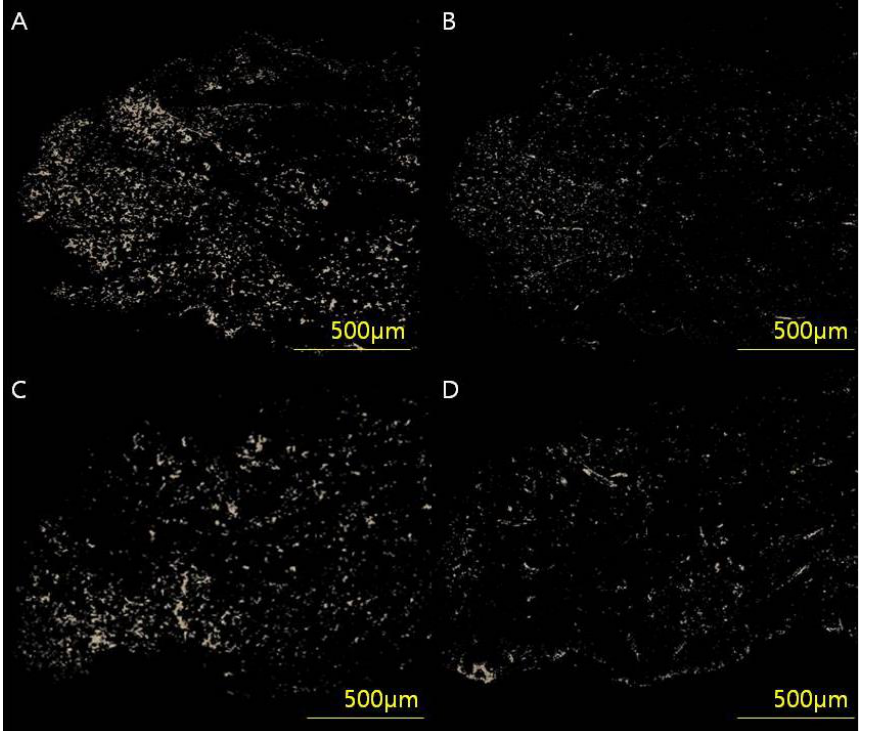
Figure 3. ( A , B ) Full-thickness skin samples from a 54-year-old woman (VSS 4) who underwent breast-conserving surgery through a periareolar incision were acquired and analyzed using an Axioscan 7 slide scanner and Zen Slide Scan digital image analysis software version 3.4.91 (Carl Zeiss GmbH, Jena, Germany). ( C , D ) Full-thickness skin samples from a 53-year-old woman (VSS 0). Six random areas (50 × 50 pixels) were captured from each image, and the quantitative areas of collagen type I/III were analyzed using digital image analysis software (Image-Pro Plus, Media Cybernetics, Silver Spring, MD, USA) and custom software to obtain collagen type I/III content and ratio. The analyzed values of ( A ) collagen type l content, ( B ) collagen type III content and type I/III ratio were 34.78 μg/g, 11.09 μg/g and 3.13, respectively. The analyzed values of ( C ) collagen type I content, ( D ) collagen type III content and type I/III ratio were 13.56 μg/g, 14.96 μg/g and 0.90, respectively.